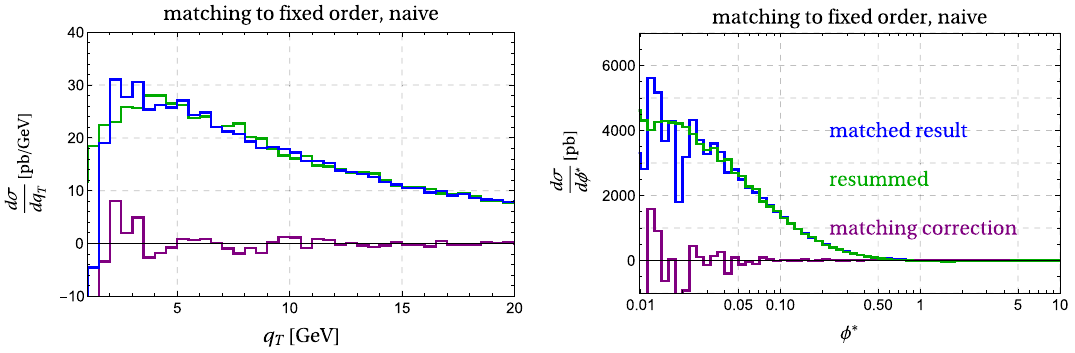
Fig. 4 Matching correction, resummed and matched result for q T and φ ∗ . The numerical noise at small q T and φ ∗ arises due to large cancellations in the naive computation of the matching